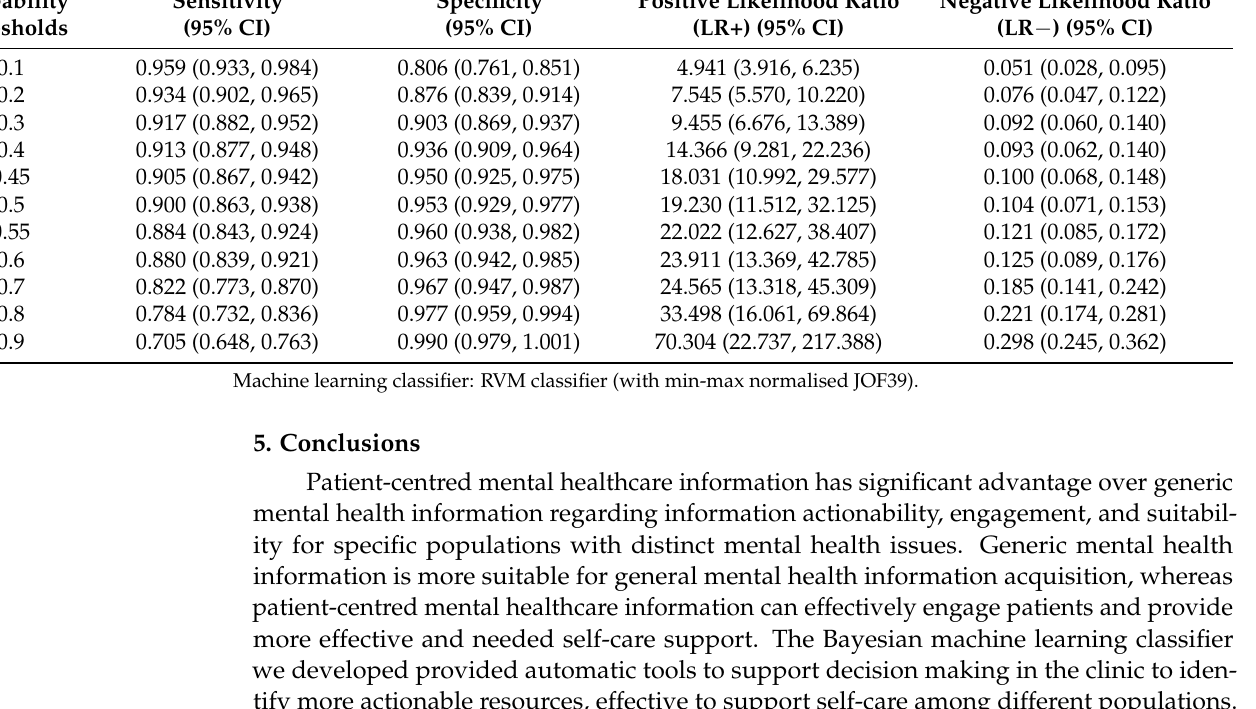
Table 4. Thresholds, positive/negative likelihood ratio, 95% CI of the best performing RVM classifier on the test data. Probability